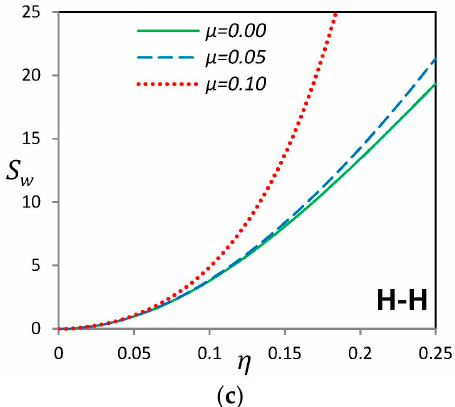
Figure 8. Effect of nonlocal parameter μ on sensitivity indicator of a nano-beam with “L 2 ” type initial imperfection for ( a ) clamped-clamped ( b ) clamped-hinged and ( c ) hinged-hinged endpoint conditions.